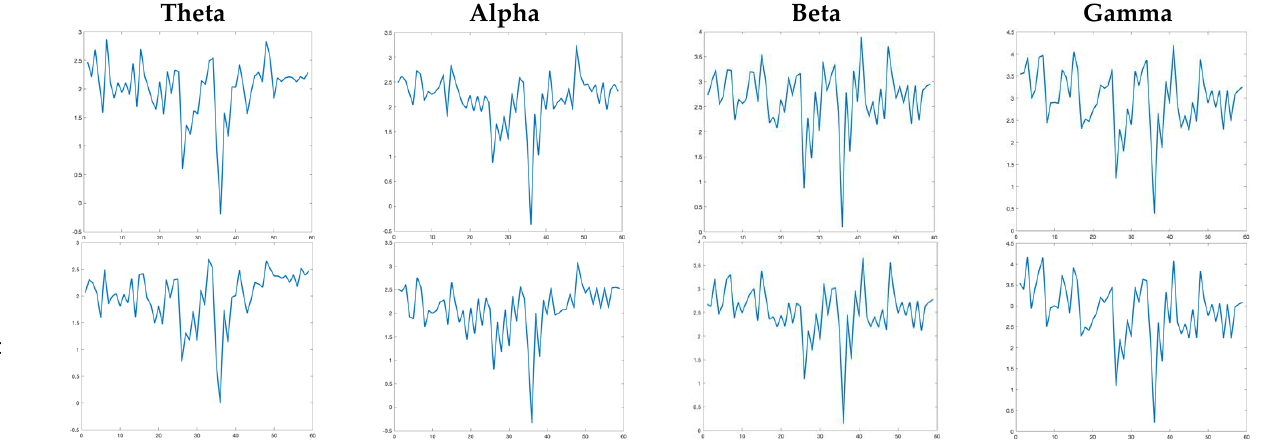
Figure 2. The calculated DE features for all channels of each rhythm for Subject-12 for positive and negative emotions where the x -axis (horizontal) shows channel number and the y -axis (vertical) shows DE value.